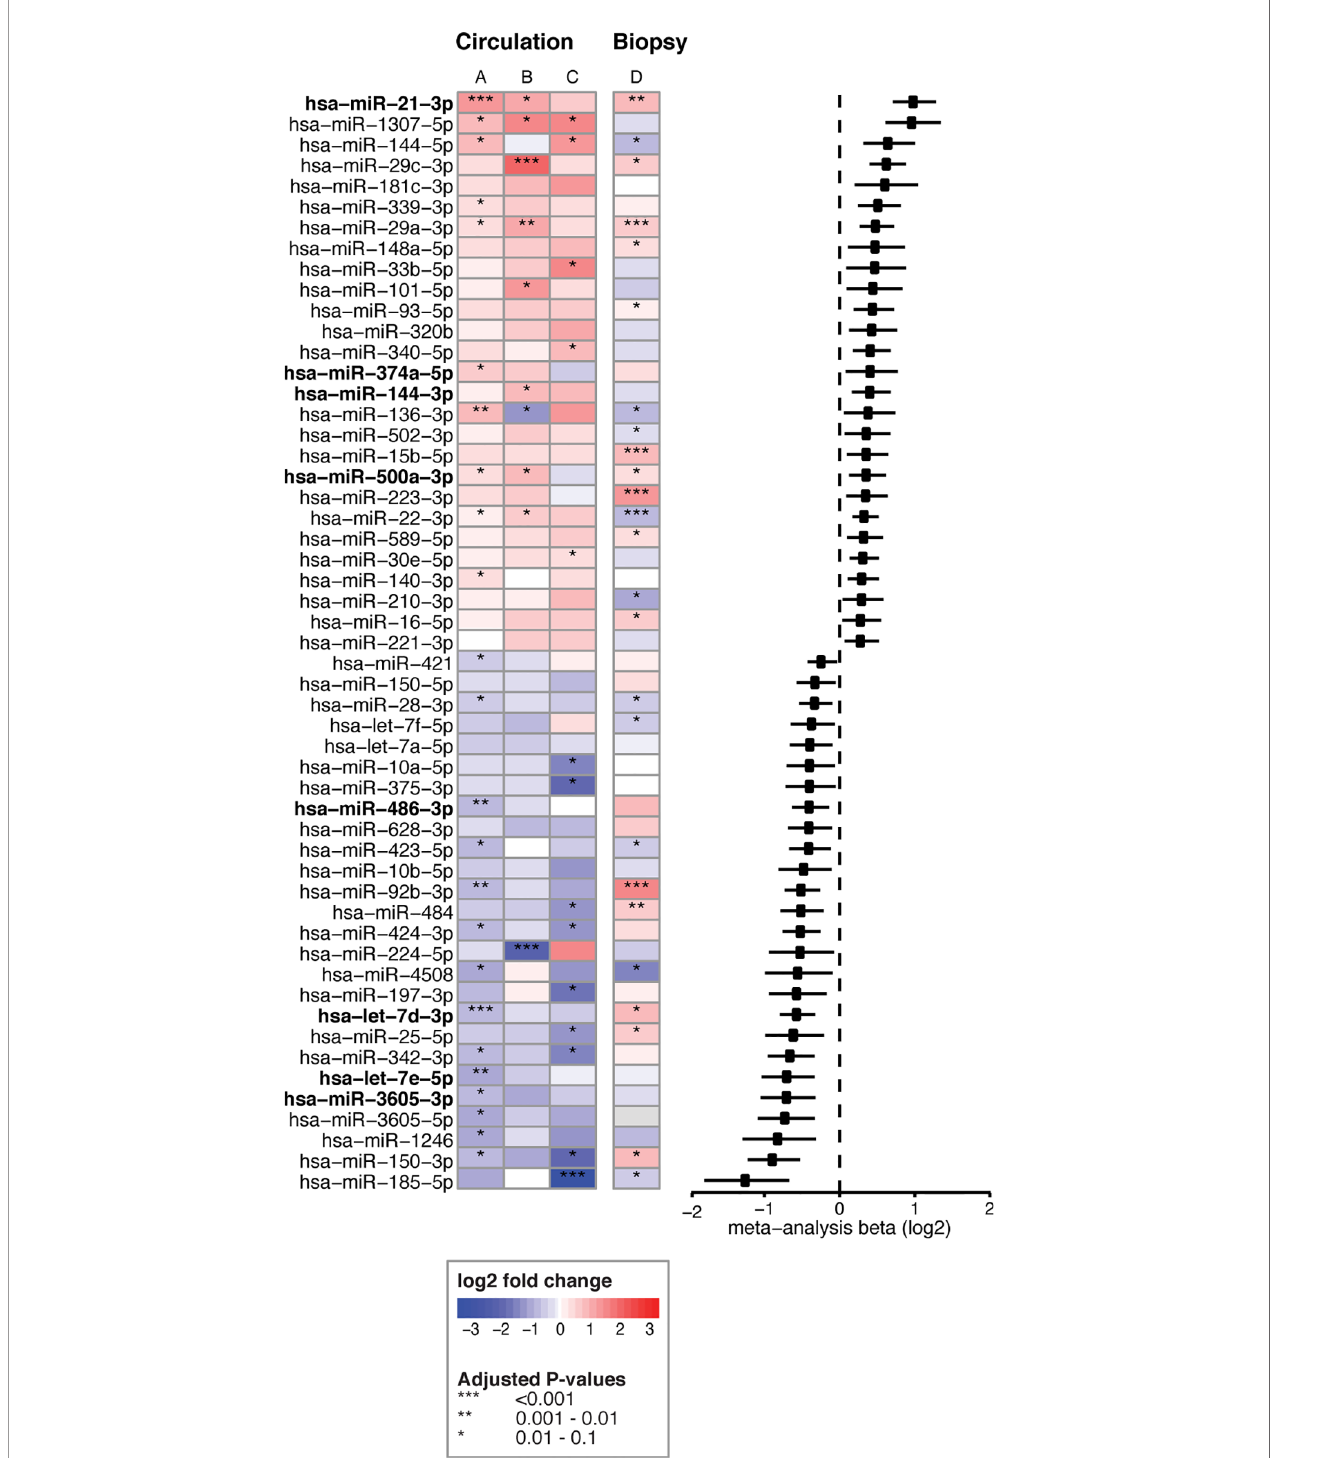
FIGURE 3 | 53 circulating miRNA biomarker candidates for CeD development. Log2fold changes are depicted for three separate differential expression (DE) analyses (A – C) of 53 microRNAs that were signi fi cant in the meta-analysiscombining these analyses. (A) PreventCD: pre-diagnosticsamples of CeD patients (IgA anti-transglutaminase (TGA)negative) versus controls. (B) PreventCD:CeD at diagnosis(at seroconversion (TGA positivity)orat diagnosticbiopsy) versus samples at 4 monthsofage (before gluten consumption). (C) Milano-Bicocca: CeDat diagnosis versus controls. (D) Milano-Bicocca: CeD at diagnosis versus controlsin intestinal biopsy samples. Right panel shows a forest plot for the meta-analysis(beta and95% con fi dence interval). miRNAs that are detectable < 12 months before diagnosisare indicated in